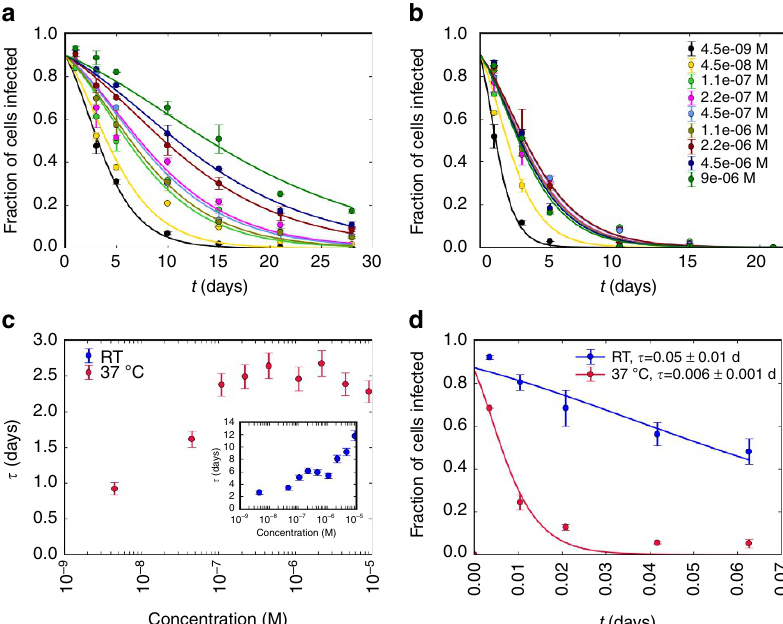
Figure 3 | Maintained Ad5 infectivity versus time in the presence of anionic NPs. ( a , b ) Fraction of cells infected versus storage time in days for Ad5 stored in presence of different concentrations of anionic MUS:OT NPs at RT ( a ) and at 37 (cid:2) C ( b ). Curves are fits to the expectation for an exponential decay of viable Ad5 particles with time. ( c ) Characteristic lifetime t extracted from the fits at 37 (cid:2) C (main panel) and at RT (inset). ( d ) Fraction of cells infected versus storage time in days for Ad5 stored in presence of cationic N , N , N -trimethyl(11-mercaptoundecyl) ammonium chloride:OT NPs at a single concentration of 10 (cid:2) 7 M in PBS at RT (blue) and at 37 (cid:2) C (red) along with the fit to the expected loss of infectivity. The experiments were performed in duplicate. Error bars represent the s.d. d, days.